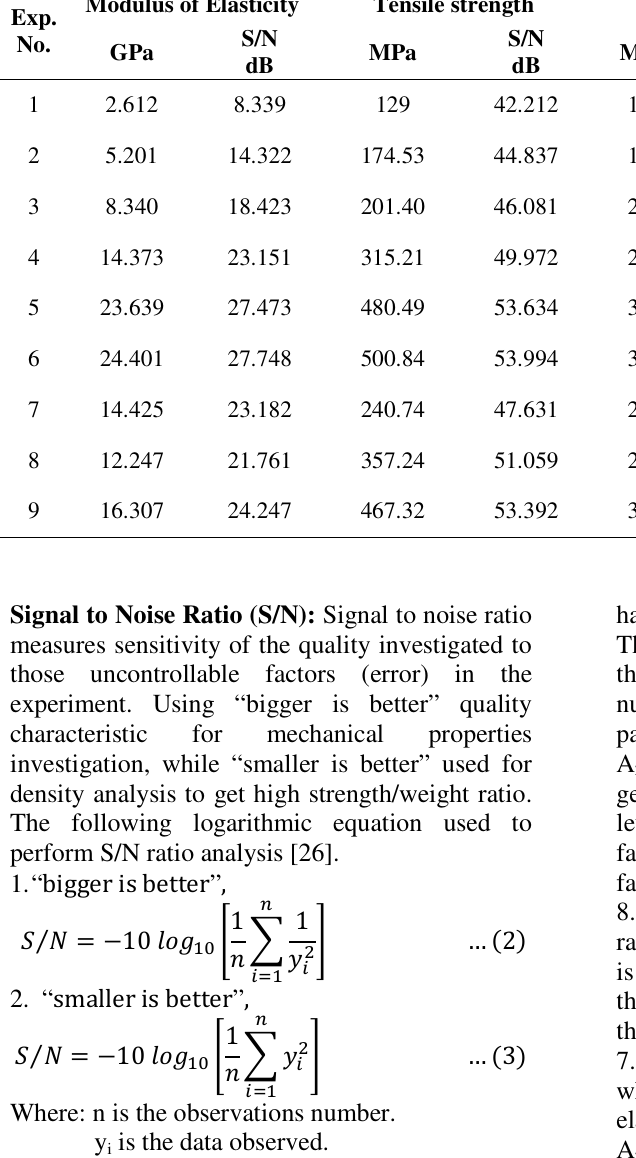
Experimental results and their signal-to-noise ratio. Exp.